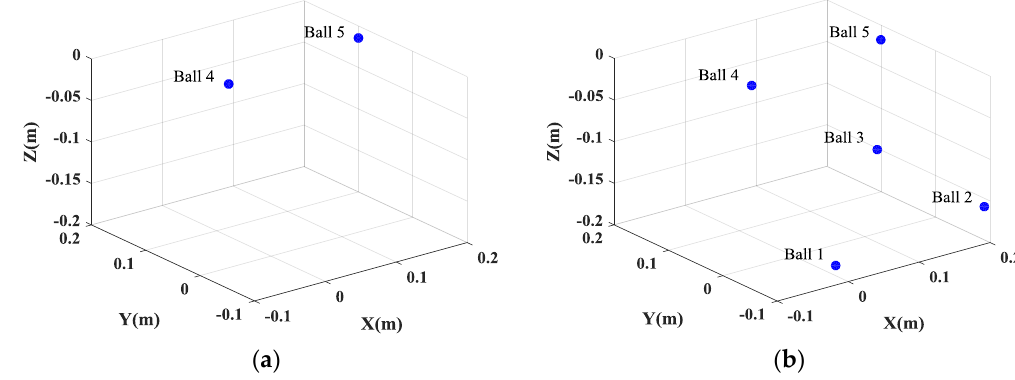
Figure 7. The recovered height information from the generated images. ( a ) Single channel CS method; and ( b ) multichannel joint CS method.